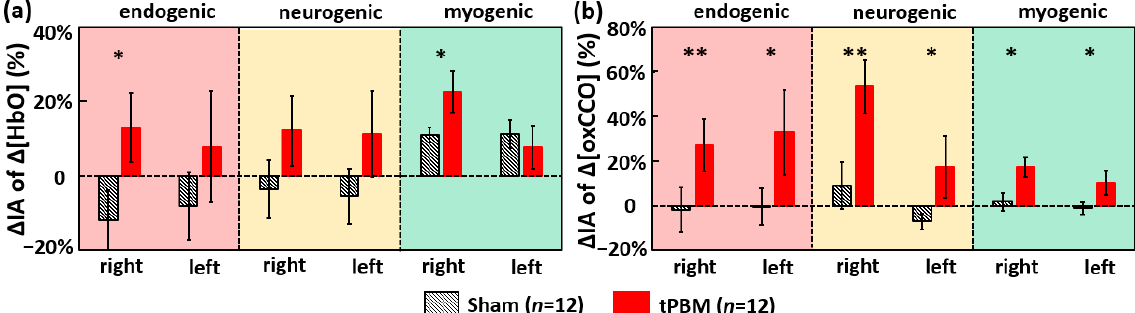
Figure 3. Baseline-normalized percentage changes of IA (i.e., Δ IA) at the bilateral prefrontal cortex for ( a ) Δ [HbO] and ( b ) Δ [oxCCO] across three ISO frequency bands. tPBM- and sham-induced Δ IA values are marked by red and black bars, respectively ( n = 12). Error bars indicate the standard error of the mean in each case. The red-, yellow- and green-shaded boxes denote the endogenic, neurogenic, and myogenic bands, respectively. “*” indicates p < 0.05, and “**” indicates p < 0.01 based on paired t -tests between tPBM and sham experiments.